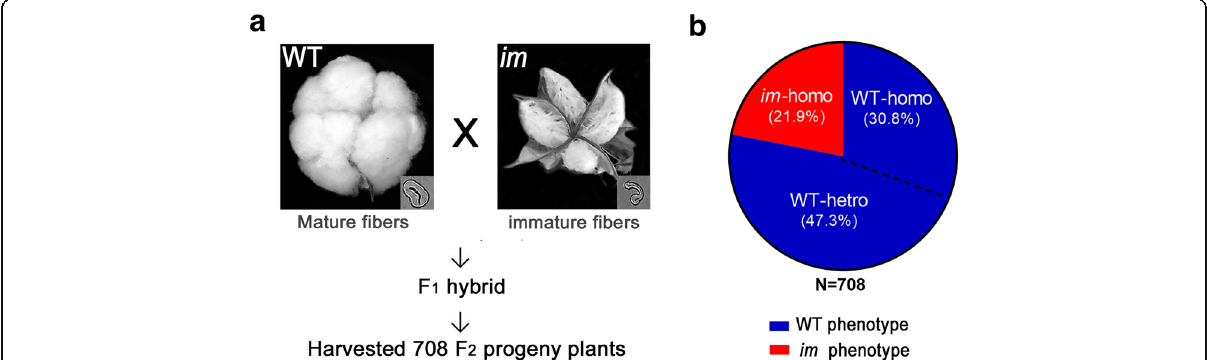
Fig. 1 Construction of the first set of cotton materials composed of a broad range of MIC value. a F 2 population of the first set. Seven hundred eight F 2 progeny plants were derived from a cross between wild-type (WT) upland cultivar MD52ne and immature fiber ( im ) mutant. MD52ne produces a phenotype of a fluffy boll, a mature fiber, and a thick wall (inset), whereas the im mutant generates a phenotype of a non-fluffy boll, an immature fiber, and a thin wall (inset). b Genotyping of the F 2 population. Genotypes including homozygosity for the wild type (WT-homo), heterozygosity for the wild type (WT-hetro), and homozygosity for the im type ( im -homo) were determined by DNA markers. The WT phenotype (blue) was predicted from the F 2 plants containing WT-homo and WT-hetro genotypes, whereas the im phenotype (red) was expected from the im -homo